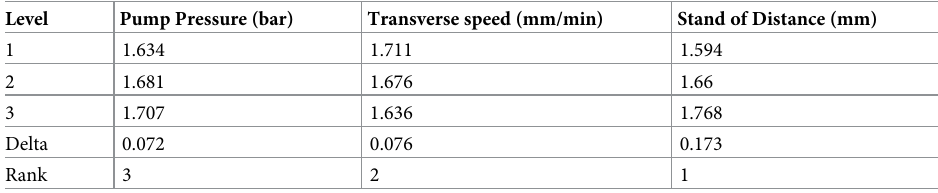
Table 10. ANOVA for 0.3 wt. % of reduced graphene oxide loaded composite. DF Seq SS Adj SS Adj MS F—Test P-value Source Pump pressure(bar) 2 0.024141 22.11 0 Transverse speed (mm/min) 2 0.025719 23.55 0 Stand of Distance (mm) 2 0.137874 0.137874 126.28 0 Error 20 0.010919 0.010919 0.000546 Total 26 0.198652 R-Square value =